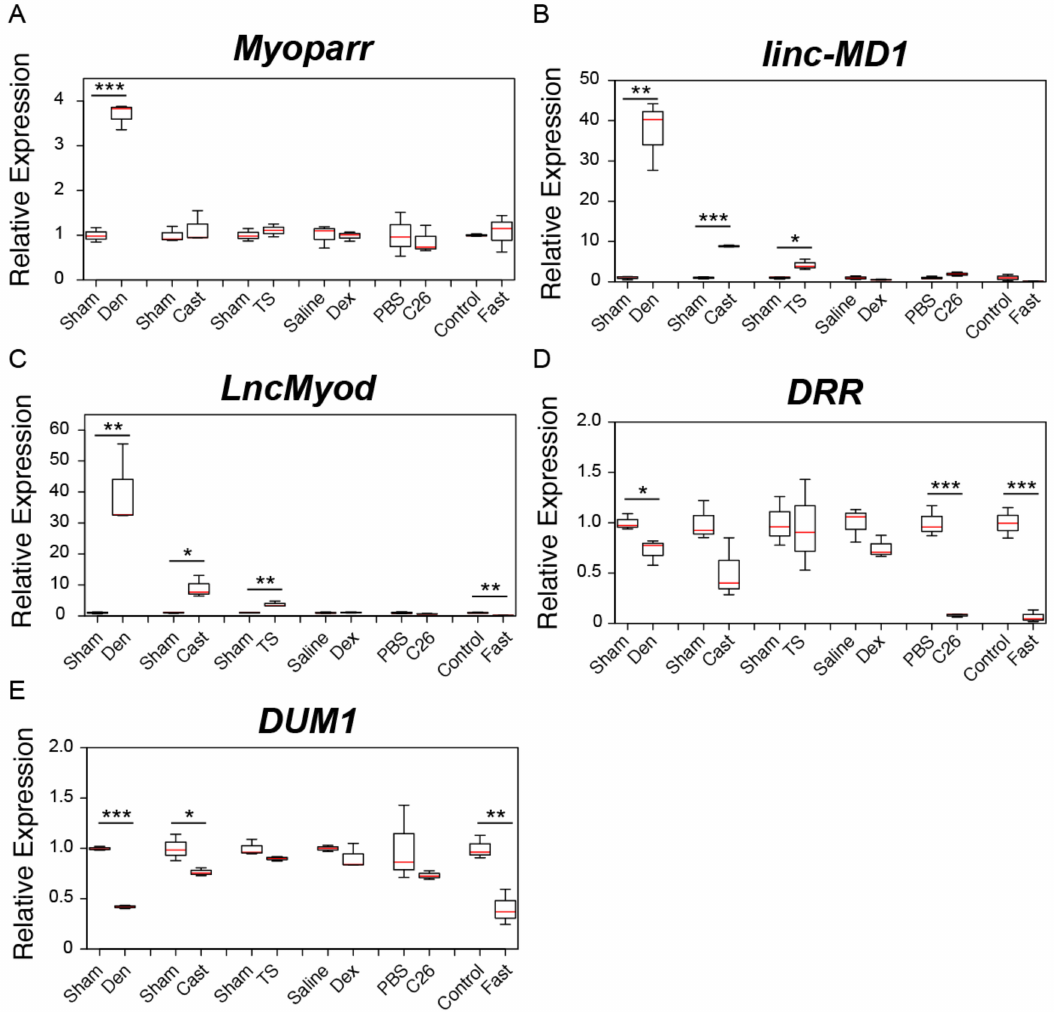
Figure 1. Changes in the expression of skeletal muscle di ff erentiation-related lncRNAs in six muscle atrophy conditions. ( A – E ) Box-and-whisker plots showing the results of quantitative RT-PCR (qRT-PCR) for Myoparr ( A ), linc-MD1 ( B ), LncMyod ( C ), DRR ( D ), and DUM ( E ) expression in multiple muscle atrophy models. Red lines indicate the median values. Lower and upper box limits are 25th and 75th percentiles, respectively. Whiskers indicate the maximum and minimum values. Sham; tibialis anterior (TA) muscles of sham-operated C57BL / 6J mice. Den; denervated TA muscles of C57BL / 6J mice. Cast; casting-operated TA muscles of C57BL / 6J mice. TS; TA muscles of tail suspension-operated C57BL / 6J mice. Saline; TA muscles of saline-injected C57BL / 6J mice. Dex; TA muscles of dexamethasone-injected C57BL / 6J mice. PBS; TA muscles of control phosphate-bu ff ered saline (PBS)-injected CD2F1 mice. C26; TA muscles of C26 tumor-bearing CD2F1 mice. Control; TA muscles of C57BL / 6J mice provided with water and food ad libitum. Fast; TA muscles of fasting C57BL / 6J mice. qRT-PCR data were normalized to Rpl26 expression and shown as relative expression. n = 3 per group. * p < 0.05. ** p < 0.01. *** p <